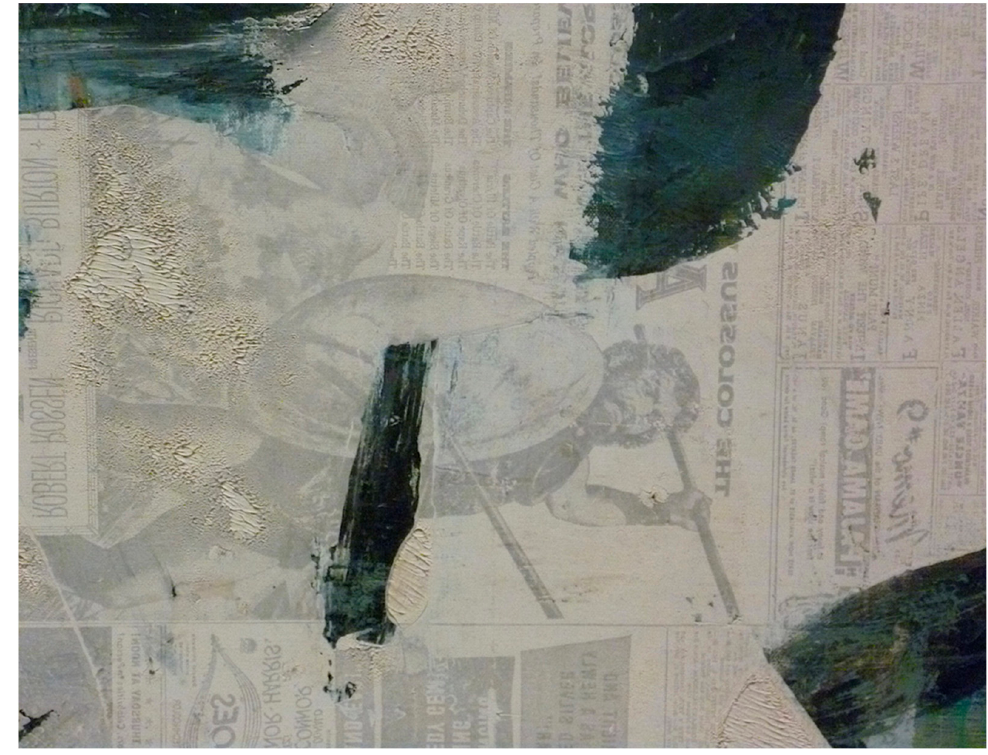
Figure 3. Easter Monday (detail).